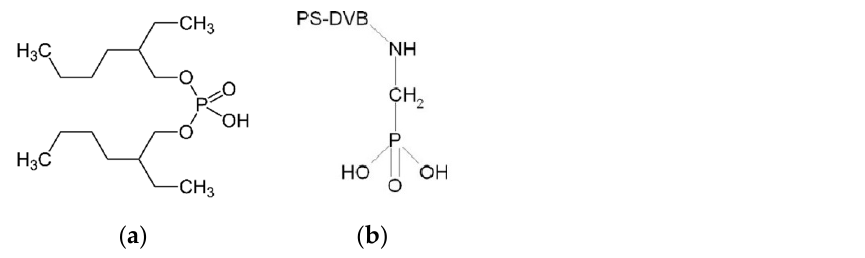
Figure 1. Functional groups of the two commercial resins ( a ) Lewatit VP OC 1026 and ( b ) Lewatit TP 260. Table 1. Resins characteristics.